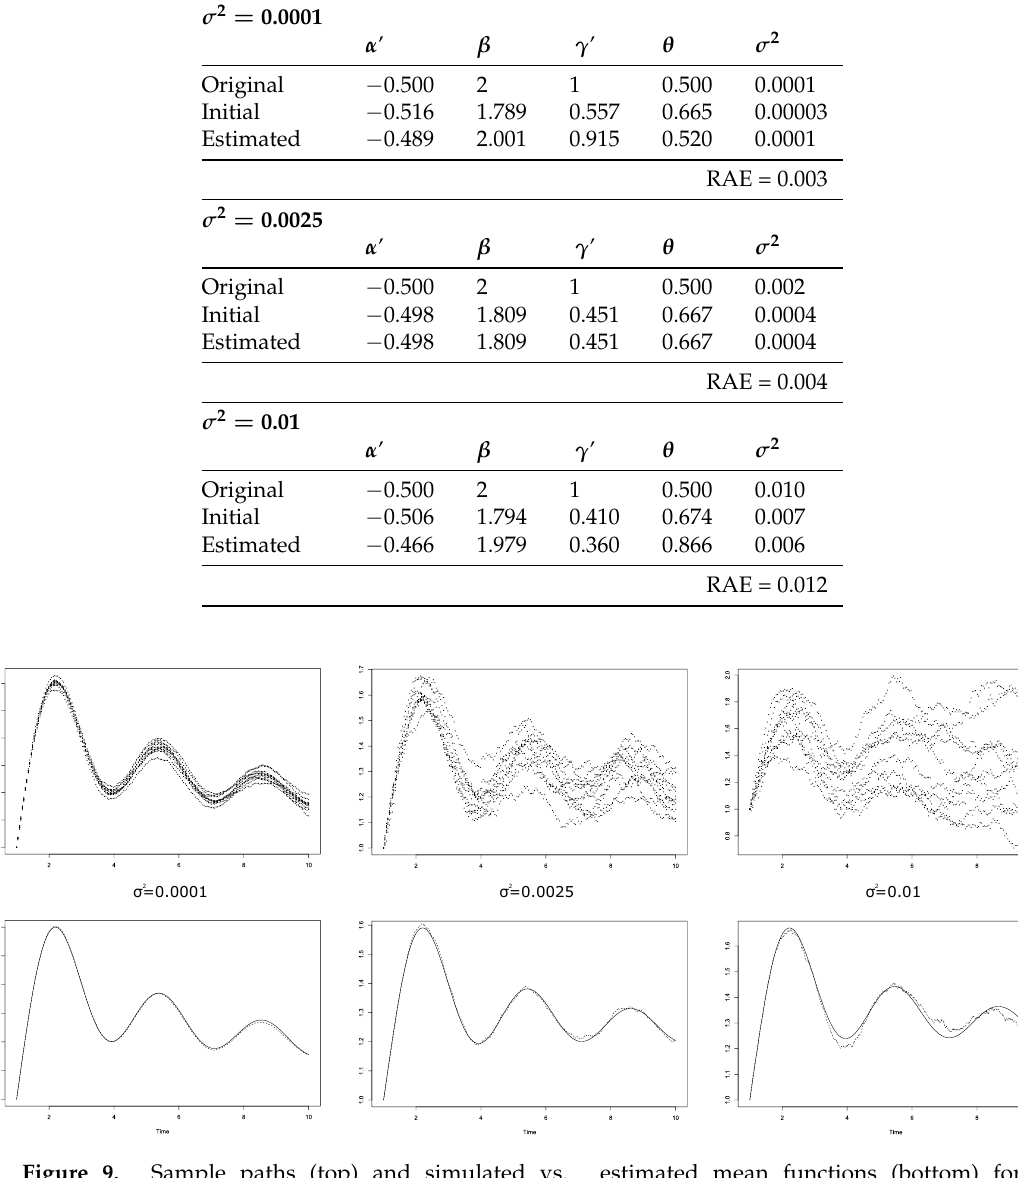
Table 6. Results for simulated lognormal diffusion for different values of σ 2 .